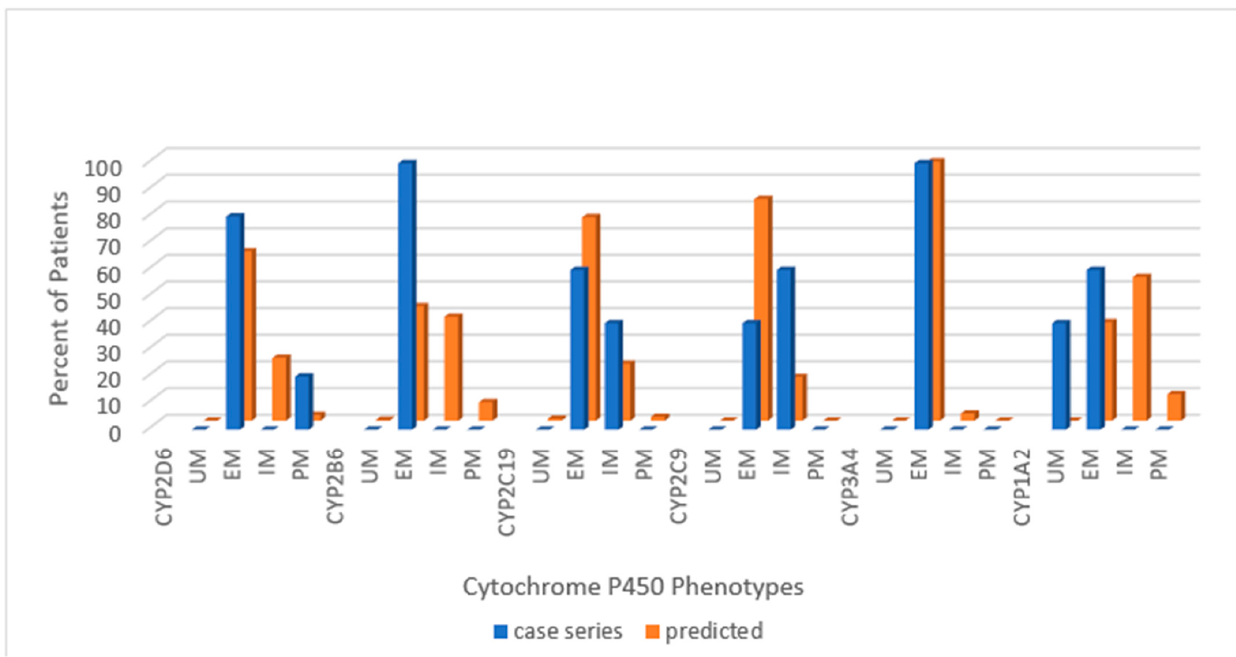
Figure 4. Distribution of Cytochrome P450 phenotypes among PWS Unspecified genetic subtype, ( n = 5) compared to normative populations [https://www.pharmgkb.org/page/cyp2d6RefMaterials]; [https://www.pharmgkb.org/page/cyp2b6RefMaterials]; [https://www.pharmgkb.org/page/cyp2c19RefMaterials]; [https://www.pharmgkb.org/page/cyp2c9RefMaterials]; [20,27]. Key: UM—ultra-rapid metabolizer; EM—extensive metabolizer; IM—intermediate metabolizer; PM—poor